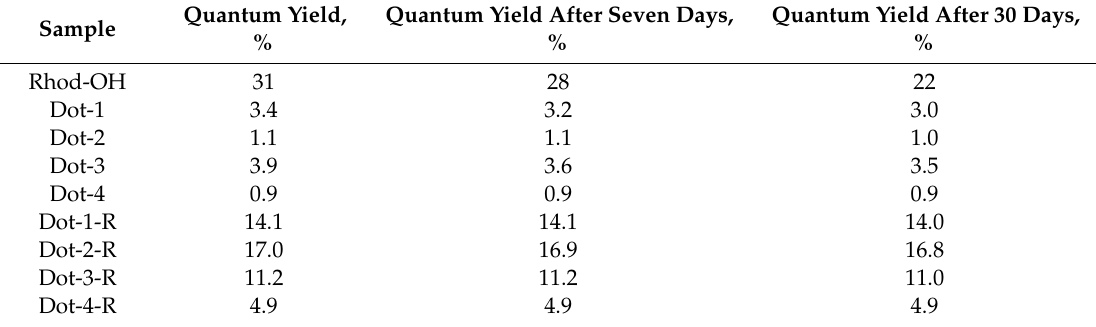
Table 2. Quantum yield determined in distilled water of the prepared CQDs and its photostability.